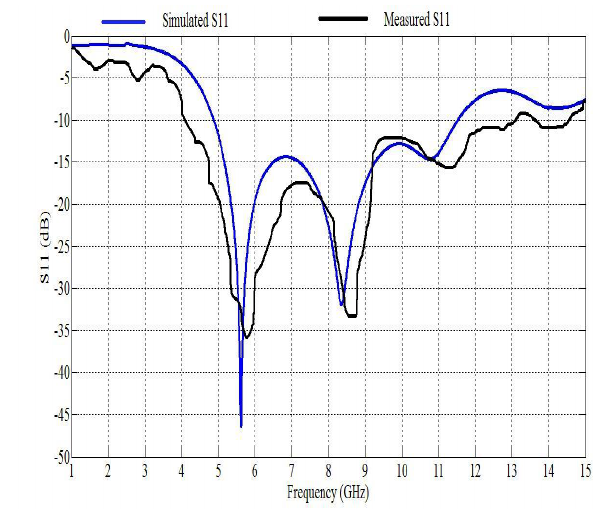
Figure 9: Simulated return loss as compared with the